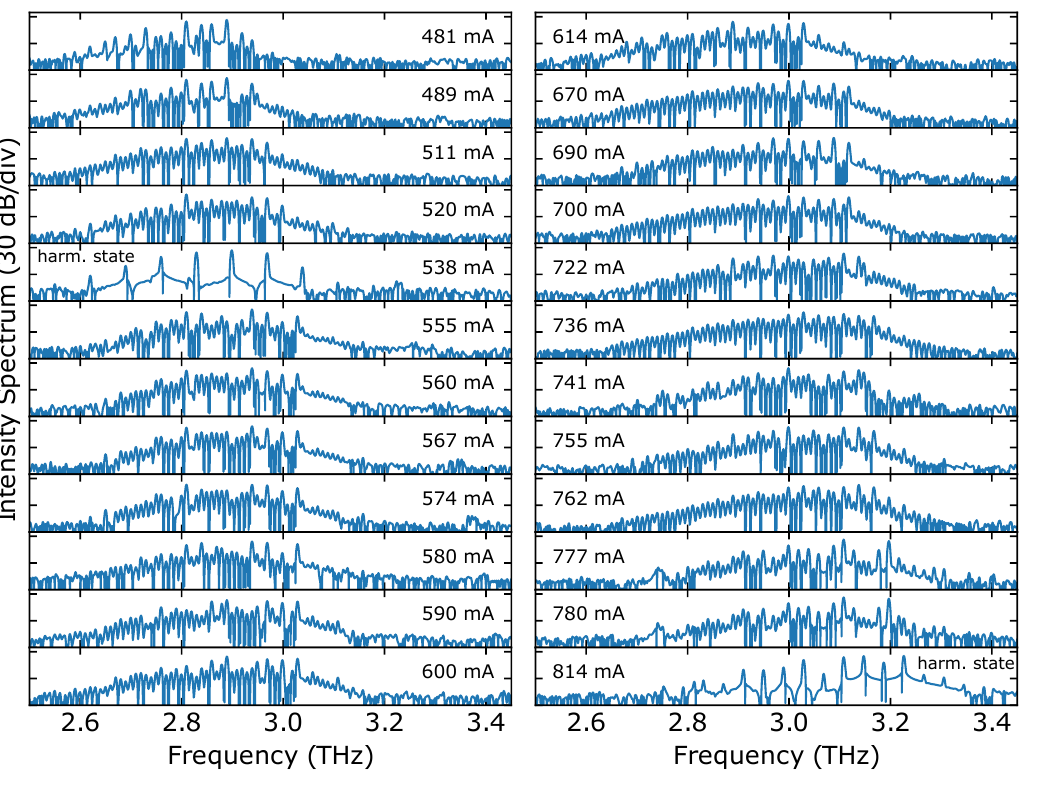
Figure 2. Spectra of a 4 mm long and 64 µ m wide device as a function of increasing injected currents at 80 K in